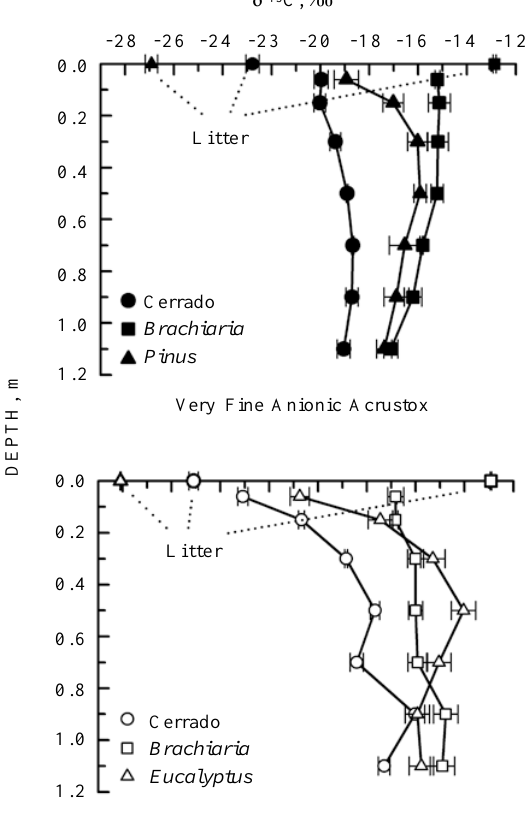
Figure 1. Distribution of δ δ δ δ δ 13 C with depth in clayey ••••• ) and coarse-loamy ( °°°°° ) Cerrado Oxisols ( subjected to different land use. Standard errors are given as error